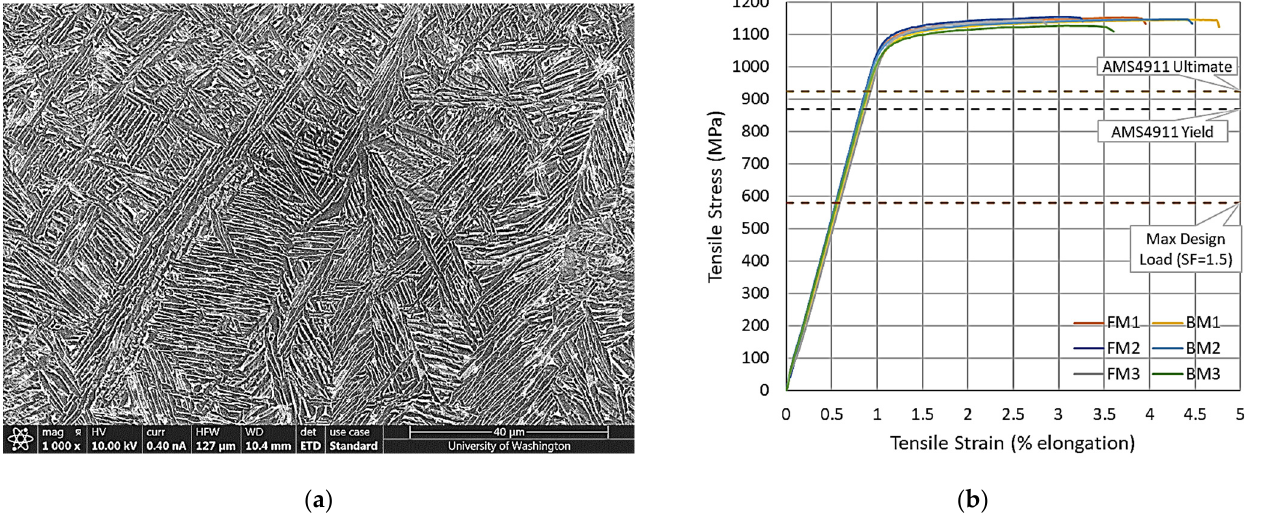
Figure 6. Properties of the additively produced specimens: ( a ) SEM image of specimen L2 microstructure at the 500 µm design thickness (up is the build direction); and ( b ) tensile properties taken from tapered box beam specimen builds 1–3, while also displaying comparisons for AMS 4911 and the maximum design load criteria.